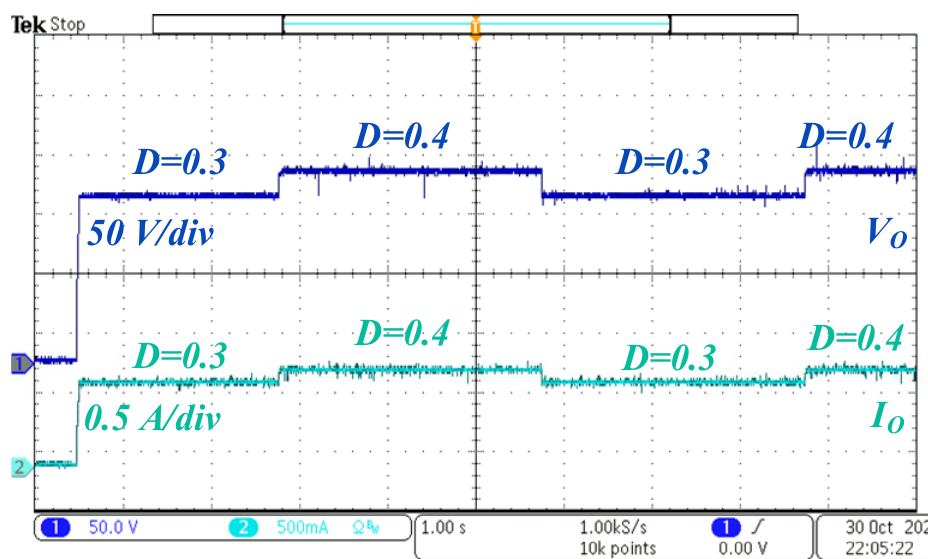
Figure 20. Effect of the change in duty on V O and I O .